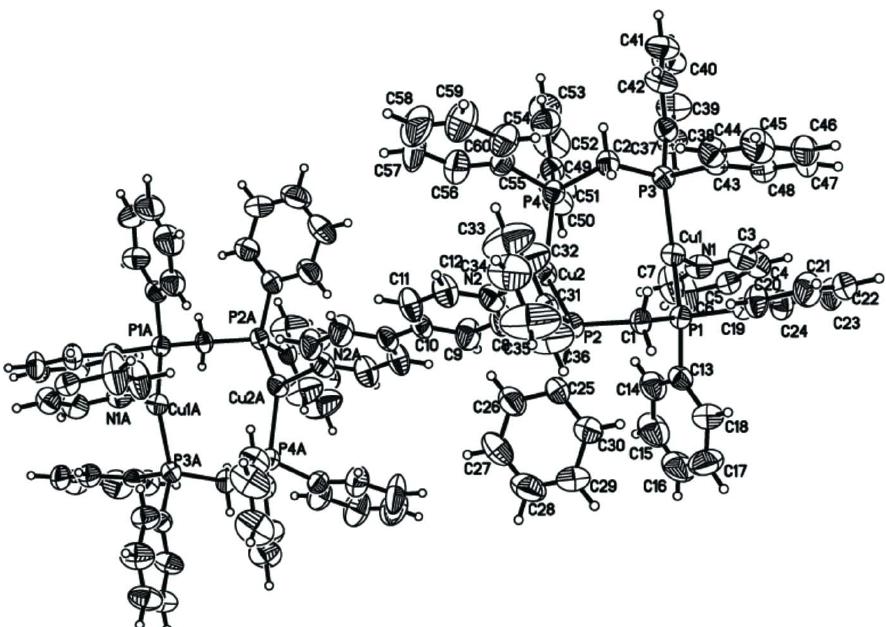
Molecular structure of the title compound showing the atom-numbering scheme and displacement ellipsoids drawn at the 50% probability level. The symmetry code for the unlabelled atoms is (- x , y , 0.5 - z ). Free (BF methane solvent molecules are not